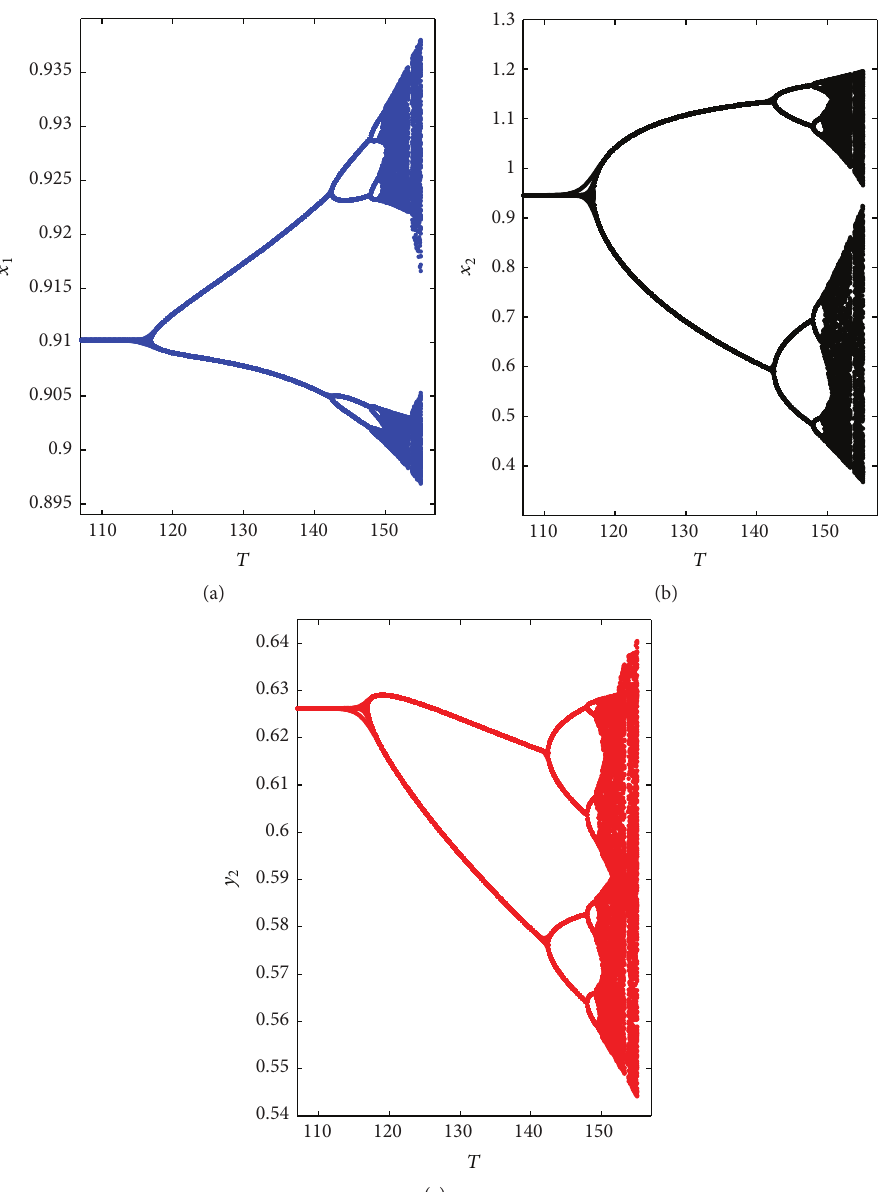
Figure 5: Bifurcation diagrams of system (3) with respect to impulsive period 𝑇 on [107, 157] . (a) Bifurcation diagrams of 𝑥 1 . (b) Bifurcation diagrams of 𝑥 2 . (c) Bifurcation diagrams of 𝑦 2 . Figure 5 indicates that bifurcation appears if 𝑇 = 118.1 , 143.9 , 147.4 , respectively, and if 𝑇 ∈ [118.1, 147.4] , more than one periodic solution appears. If a moderate pulse is given ( 𝑇 > 147 ), then the system shows chaotic phenomenon. The bifurcation diagrams include stable solutions, cycles, cascade, and chaos.